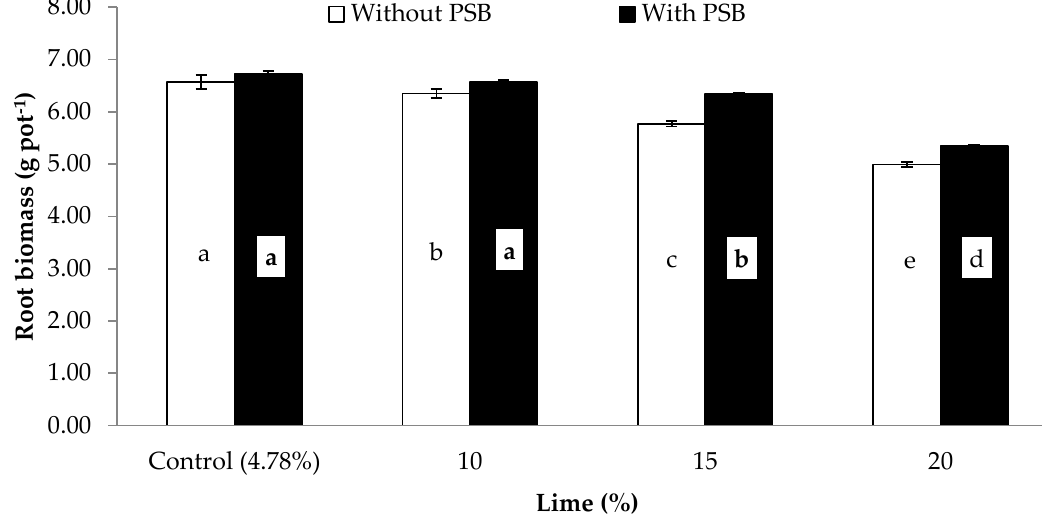
Figure 2. Associative effect of PSB and lime stress on root biomass (g pot −1 ) of maize. Bars sharing letters are statistically comparable at p < 0.05 according to least significance difference (LSD) test. Error bars show standard error (n = 3).